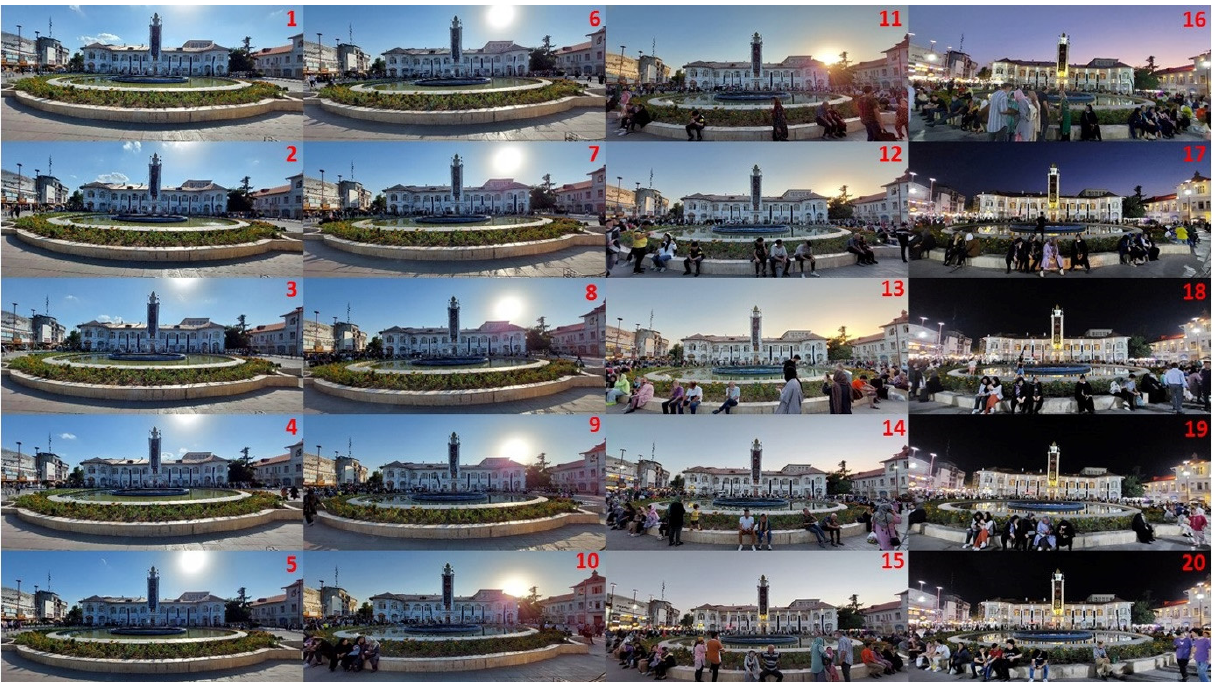
Figure 9. Pictures captured in front of the main landmark of the city between 5.00 p.m. and 10.00 p.m. using the time-lapse photography method. Each number was captured at a regular interval of every 15 min in order to follow up the possible transformations in the crowded communities.